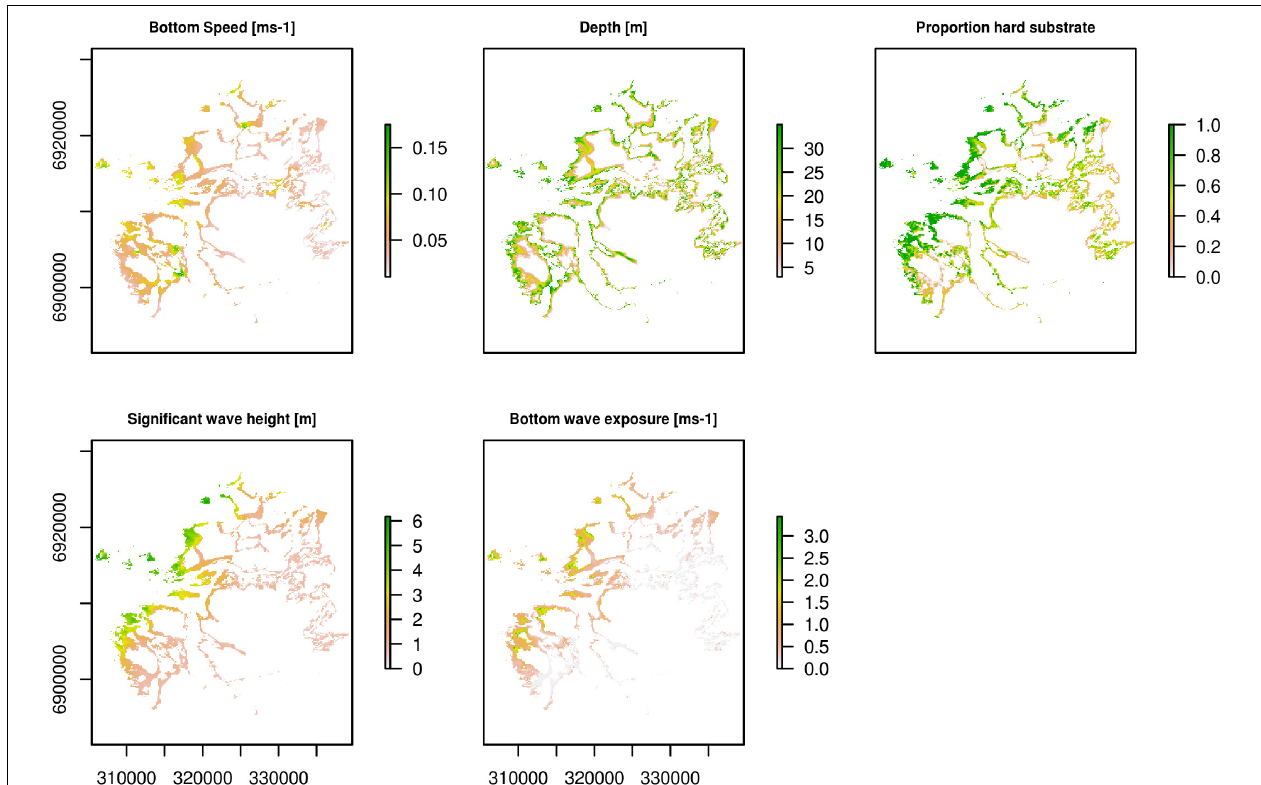
FIGURE 2 | Raster plots of environmental covariates used in the fitted GAM models. Plots show values for areas shallower than 35 m. Coordinates in WGS84